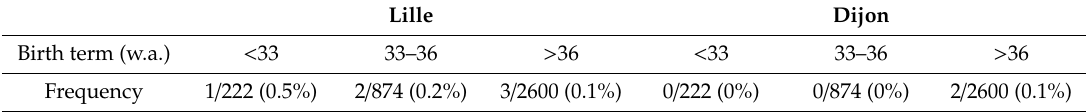
Table 1. Frequency of the alert set 1, as a function of the birth term. w.a.: Weeks of amenorrhea. Lille Dijon Birth term (w.a.)